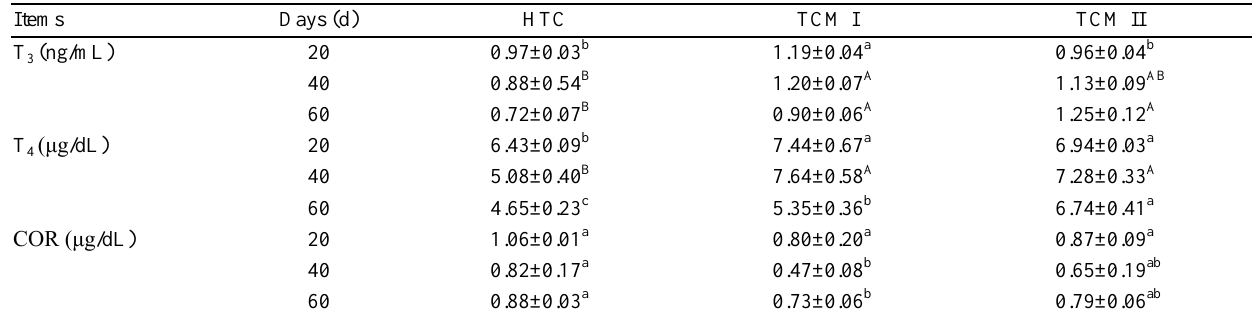
Table 4. Effects of two TCM treatments on thyroid hormones and cortisol of heat stressed beef cattle Items Days (d) HTC TCM I TCM